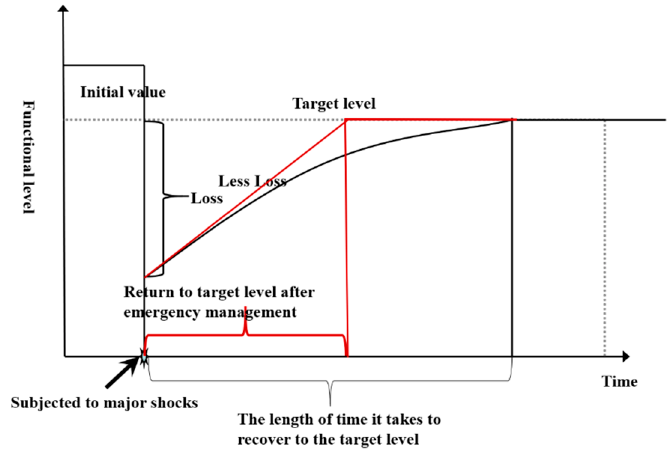
Figure 5. Impact comparison of the city safety resilience curve after emergency management.